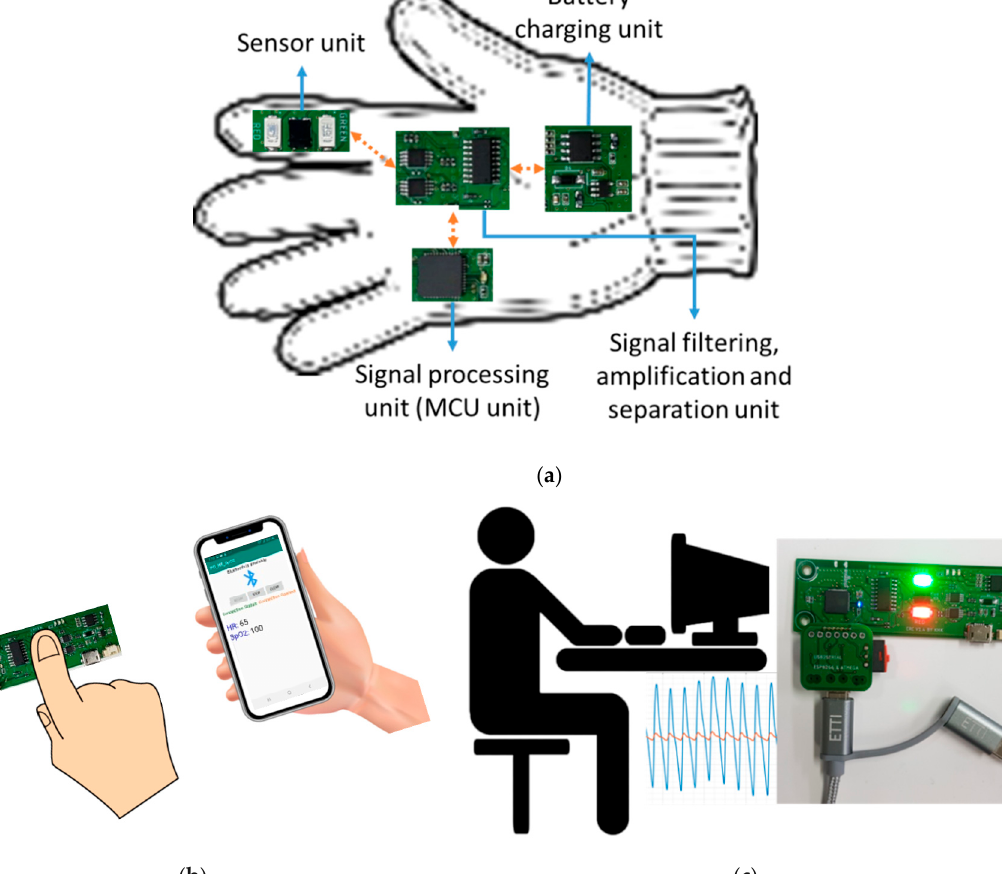
Figure 28. Applications of our proposed wearable PO device: ( a ) possible idea of wearable finger PO device, ( b ) handheld type application of our proposed wearable PO device, and ( c ) data acquisition type application of our proposed wearable PO device.